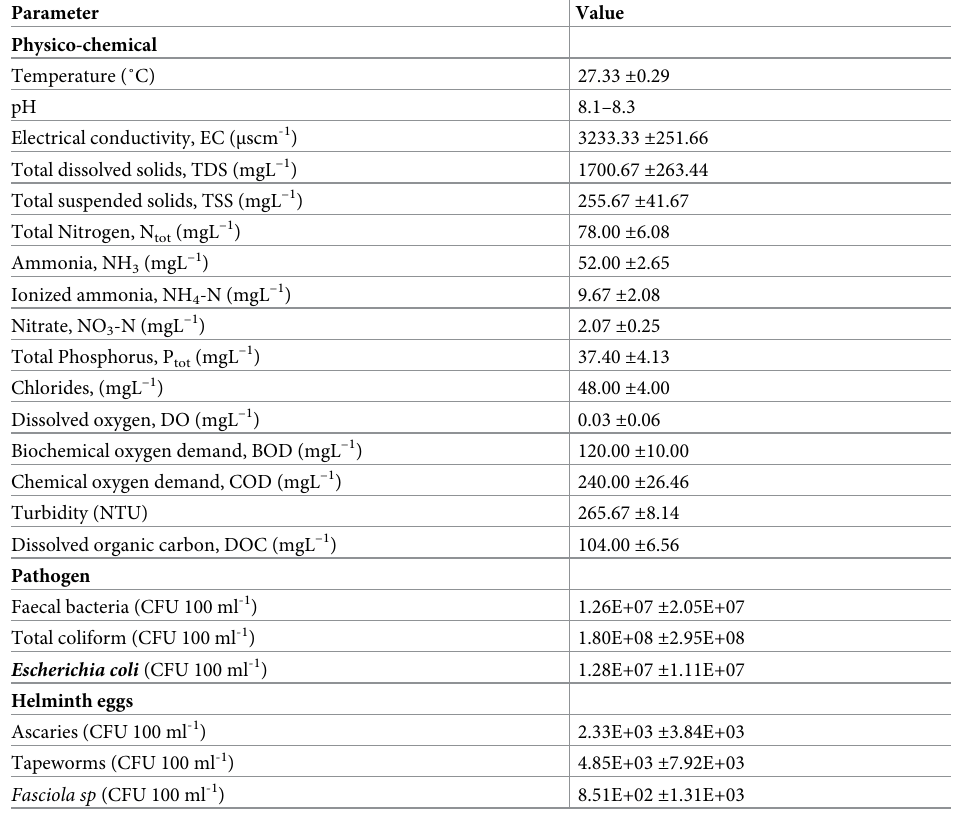
Table 1. Physicochemical, pathogen and helminth characteristics of wastewater (mean ± S.D.; n =